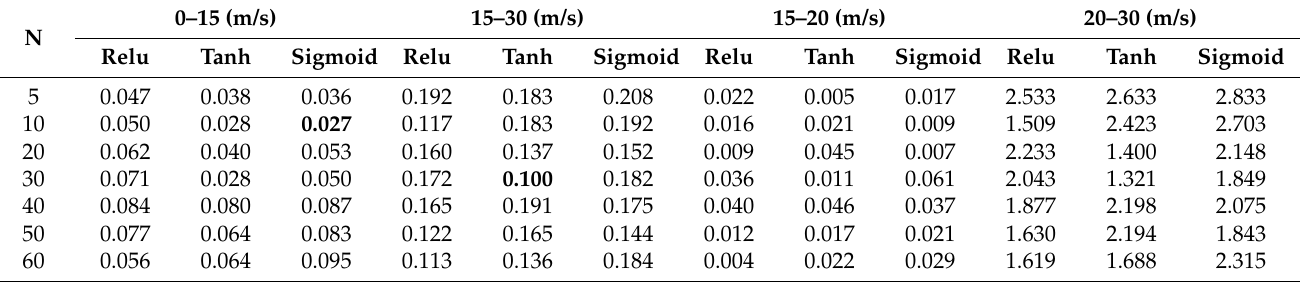
Table 7. MDs of the ANN